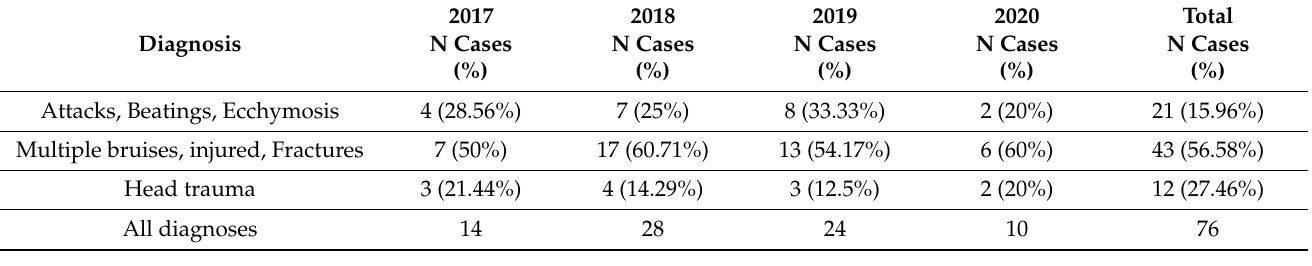
Table 2. Number of cases of violence against women classified based on the diagnosis. Both the number of cases and the percentage of the total for each year are reported.